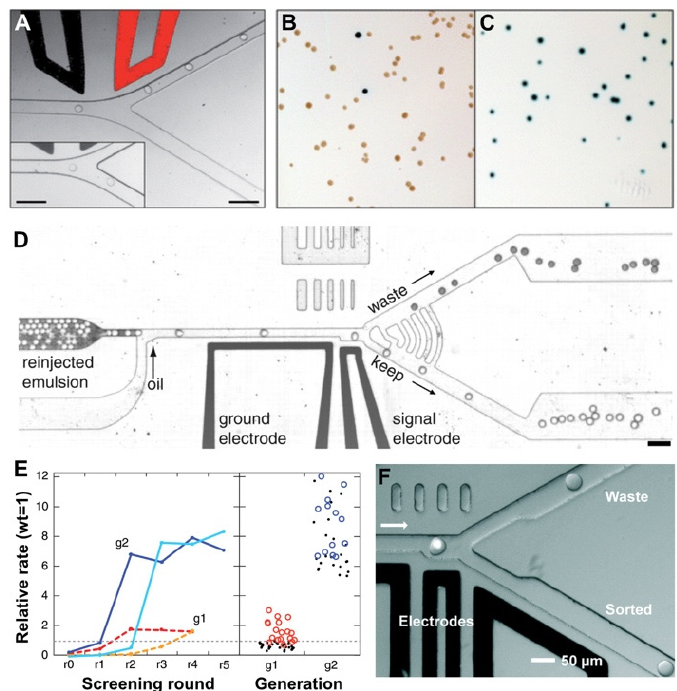
Figure 4. Fluorescence-activated droplet sorting systems. ( A ) Trajectories of droplets flowing through the sorting junction of a FADS system. When an AC electric field is applied across the electrodes, the droplets are deflected into the ‘positive’ arm. In the absence of the electric field, the droplets flowed into the ‘negative’ arm by default (inset). ( B , C ) Enrichment of cells by FADS based on β -galactosidase activity. Photographs of E. coli colonies before (B) and after sorting (C). The lacZ bacteria (blue colonies) were completely purified from the ∆ lacZ bacteria (white colonies) after sorting, resulting in only lacZ colonies growing on the agar. Figure 3A–C were adapted from Reference [30] with permission from the Royal Society of Chemistry. ( D ) A di ff erent design of the FADS system. The droplets flow as a solid plug to a junction where oil is added to space the droplets. Light droplets contain 1 mM fluorescein and the dark ones contain 1% bromophenol blue. When a droplet passes by the laser that is focused on the channel at the gap between two electrodes, its fluorescence intensity is detected. If the intensity is above a threshold (in the case of light droplets), the droplet is sorted by dielectrophoresis towards the bottom channel. ( E ) Enrichment of library pools. The activities are normalized relative to wild-type HRP. The first-generation epPCR and saturation mutagenesis libraries (dashed red and orange, respectively) enrich to a level of about two times the activity of the wild type after four sorting rounds. The second-generation low- and high-mutation rate libraries (solid blue and cyan, respectively) enrich to about eight times the wild type. The right panel shows a dot plot of the activities of the 50 unique first-generation (g1) mutants (red circles) and 31 second-generation (g2) mutants (blue circles). Figure 3D,E were adapted from reference [19], complying with the License for PNAS Articles. ( F ) The sorting junction of another FADS system. Single droplet fluorescence was detected following excitation by the laser (the white dot). The default flow path of the droplet is towards the top ‘waste’ channel since the waste outlet is at atmospheric pressure and a withdrawal of less than half the total flow rate is applied to the ‘sorted’ outlet. However, if the droplet fluorescence exceeds a predefined threshold an electric field is activated between the electrodes, pulling the droplet to the bottom channel. Figure 3F was adapted from Reference [47] with permission from the Royal Society of